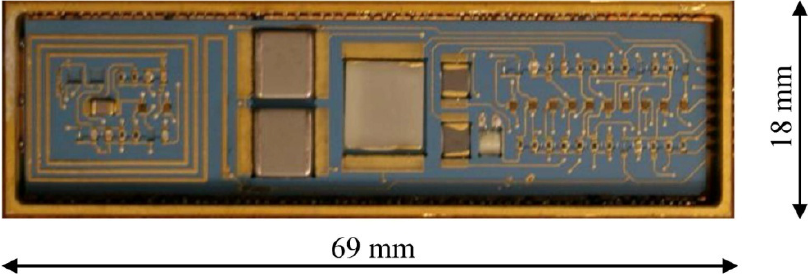
Figure 14. A prototype electronic system packaged with high temperature and high g-load capable die attaches and wire bonds.